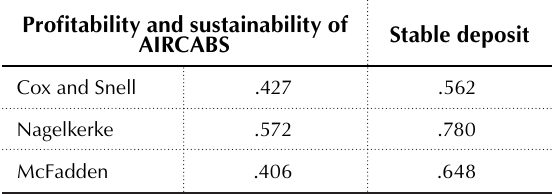
Table 25. Pseudo R-square